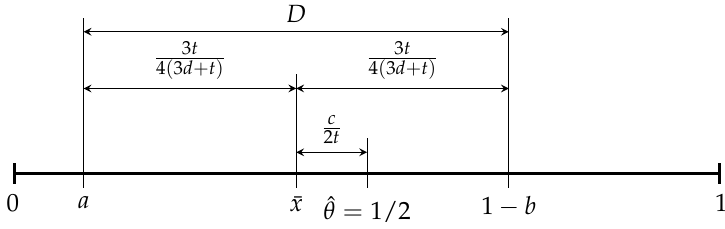
Figure 1. Subjective and social effects of consumer environmental awareness